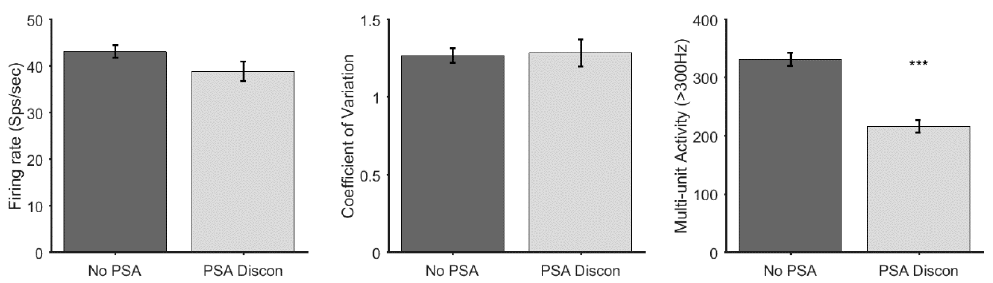
Figure 2. Bar plot and t-test for within awake group analysis for firing rate, defined in spikes per seconds, coefficient of variation and multi-unit activity, defined as activity above 300HZ. Mean and standard error are shown in each bar. *** p < 0.001. PSA: procedural sedation and analgesia.